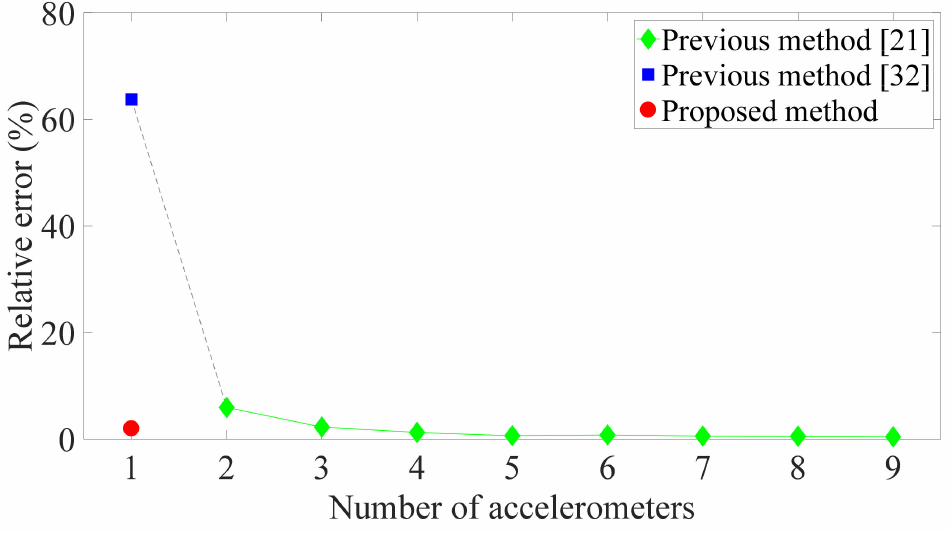
Figure 6. Relative error of first floor’s peak inter-story drift of nine-DOF structure for the method in [21] (which uses two or more accelerometers), method in [32] (one accelerometer), and proposed method (one accelerometer) when only two modes are included in the model.